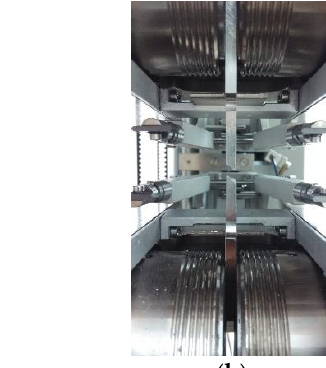
Figure 8. Scheme of the specimens for tensile test extracted from different orientations. Tensile tests were performed in a model Z100 ZWICK/Roell testing machine, ZWICK/Roell, Ulm, Germany with a maximum load capacity of 100 kN. Specimens were tested at room temperature with a displacement rate of 1.6 mm/min and using an extensometer with a gauge length of 25 mm (Figure 9).